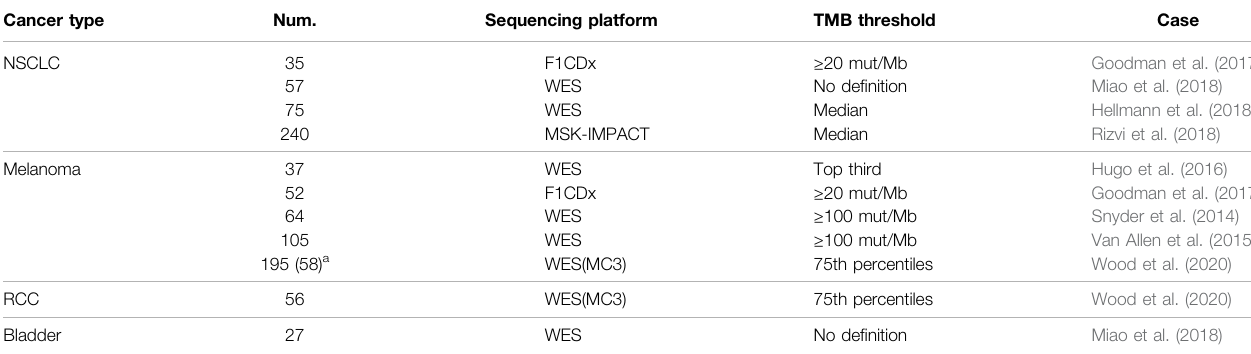
TABLE 3 | Patient cohorts from the published literatures.